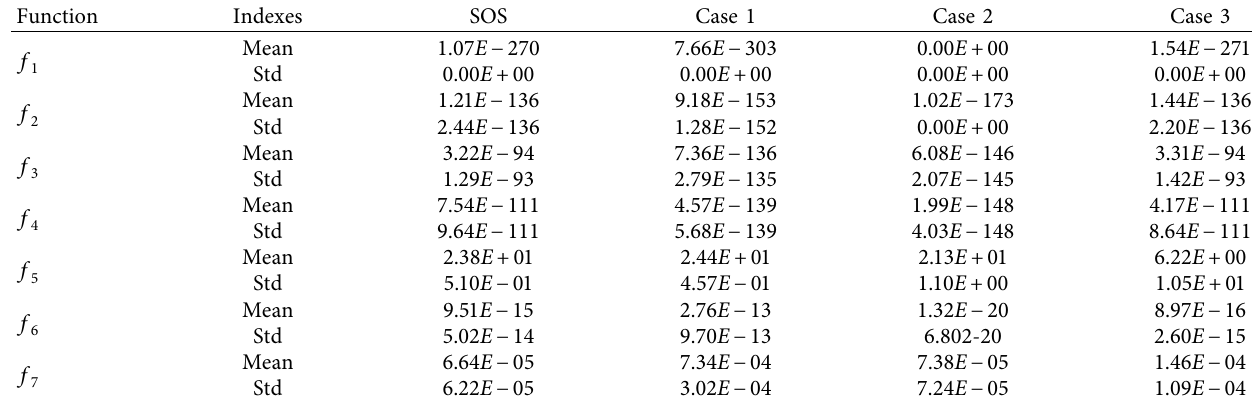
Table 6: Efect of the three cases on the SOS for unimodal functions.